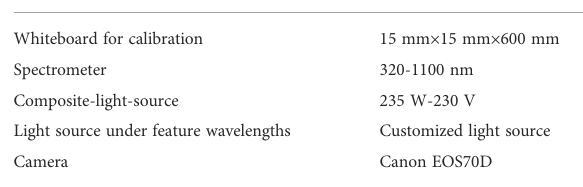
TABLE 1 Main equipment list for the hardware platform of the detection